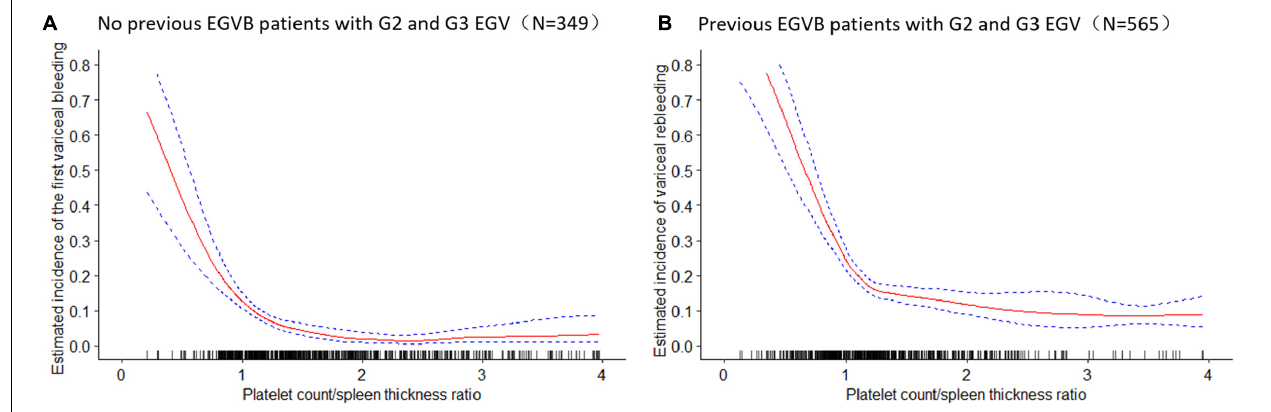
FIGURE 4 | The estimated incidence of the variceal bleeding and 95% confidence intervals of variceal bleeding within 1 year in cirrhotic patients with moderate or severe esophagogastric varices. (A) The estimated incidence of the first variceal bleeding (%) and 95% confidence intervals of first-time variceal bleeding in cirrhotic patients with moderate and severe esophagogastric varices. (B) The estimated incidence of variceal rebleeding (%) and 95% confidence intervals of variceal rebleeding in cirrhotic patients with moderate and severe esophagogastric varices. EGVB, esophagogastric variceal bleeding; G2, moderate grade of esophagogastric varices; G3, severe grade of esophagogastric varices; EGV, esophagogastric varices.